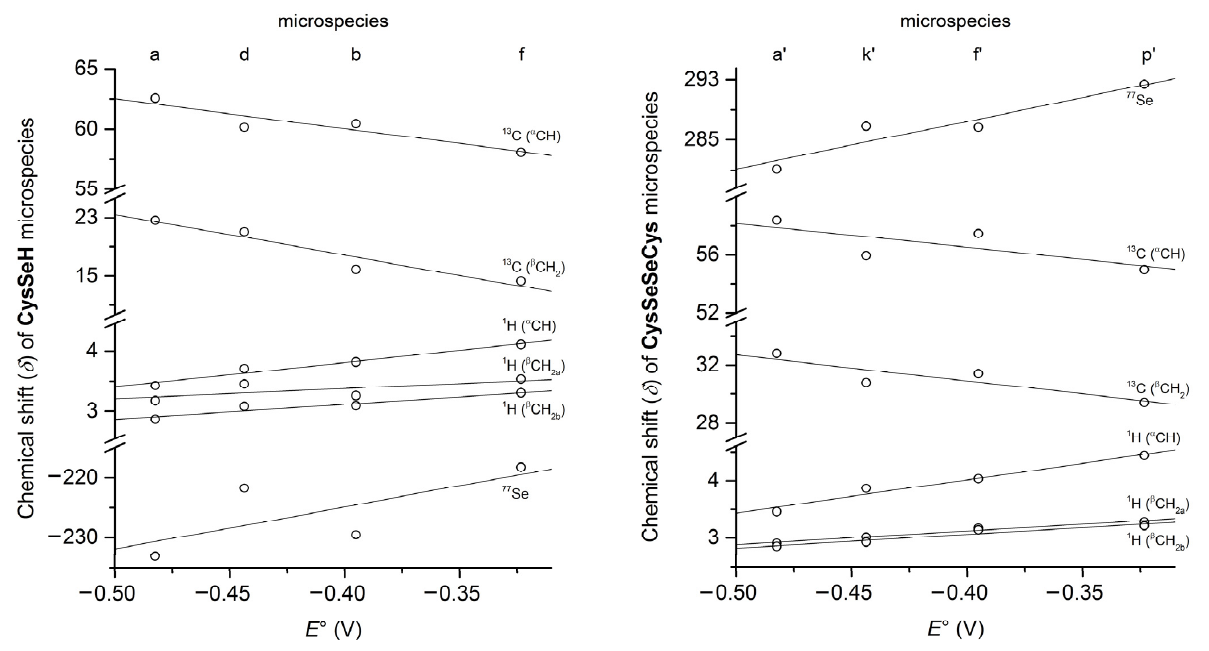
Figure 8. Correlation of selenocysteine standard redox potentials with the corresponding seleno- cysteine microspecies chemical shifts ( left ) and selenocystine microspecies chemical shifts ( right ). Reproduced from